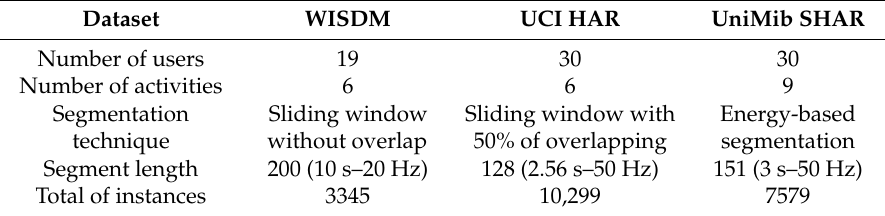
Table 1. Summary of dataset characteristics used in experiments